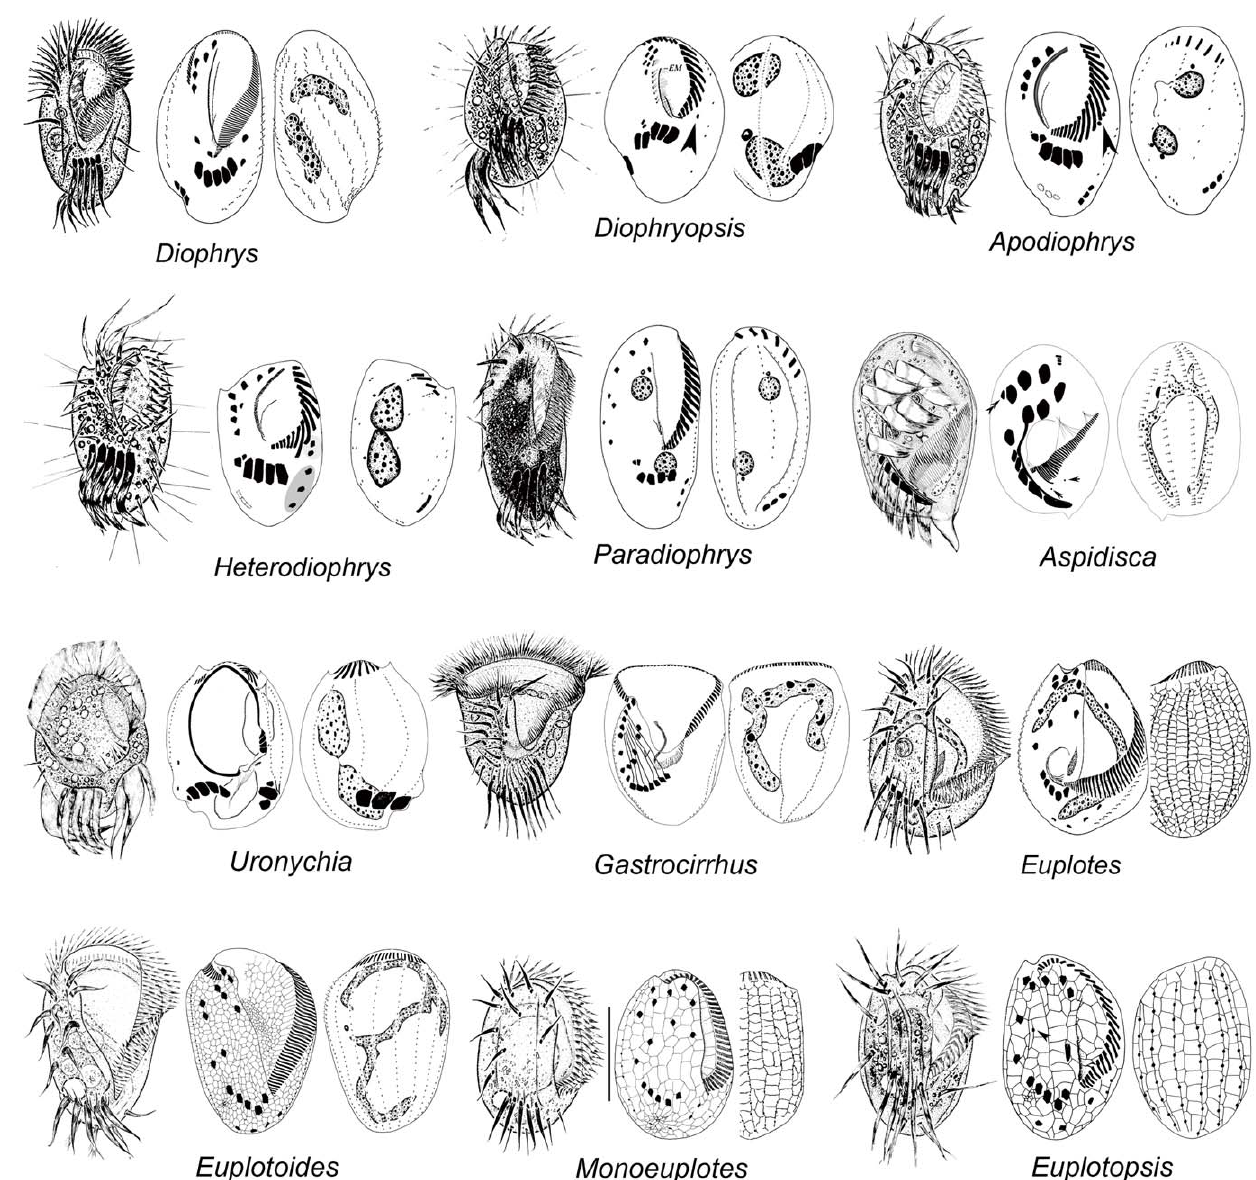
Figure 1. Representative euplotid species from live material and after protargol impregnation.